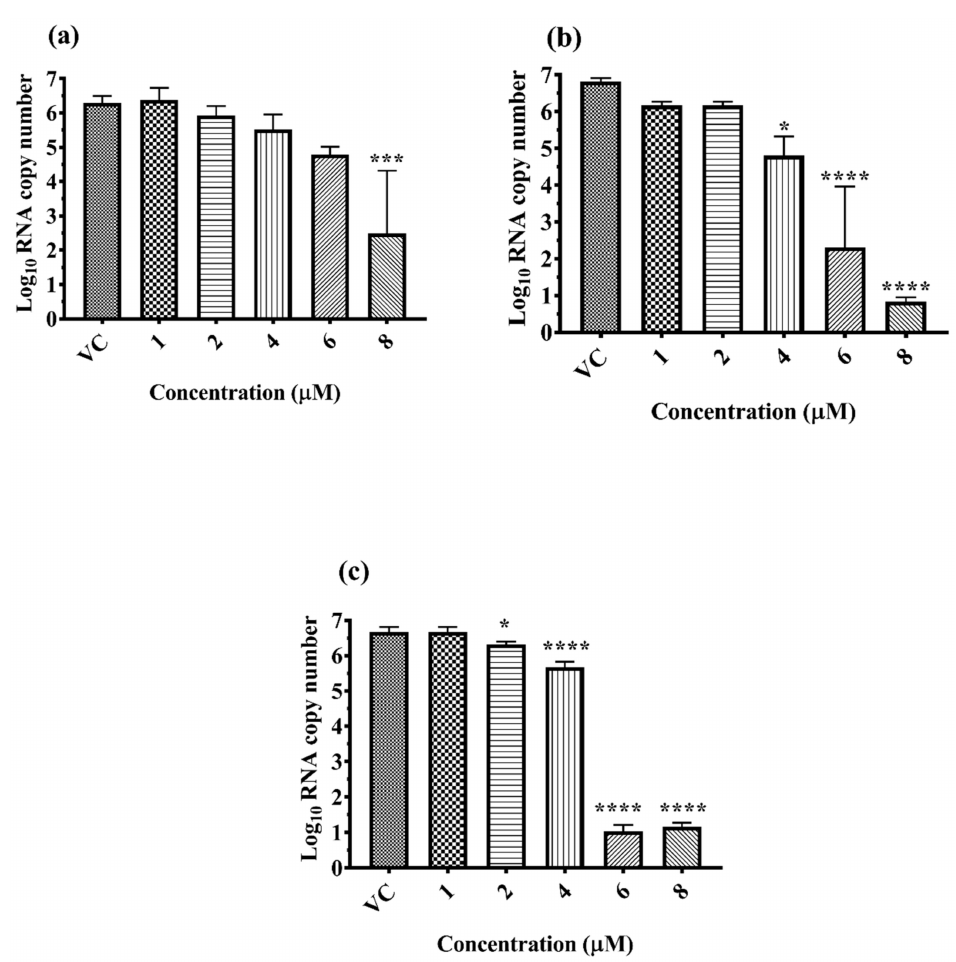
Figure 2. Effect of α -Mangostin on DENV-2 RNA levels, quantified by qRT-PCR under pre-treatment ( a ), co-treatment ( b ) and post-treatment ( c ) conditions. The fold change was compared with the virus control (VC) and presented logarithmically. All the values are expressed as mean ± SD of three experiments **** p < 0.0001; *** p = 0.0002; and * p = 0.0194 vs.